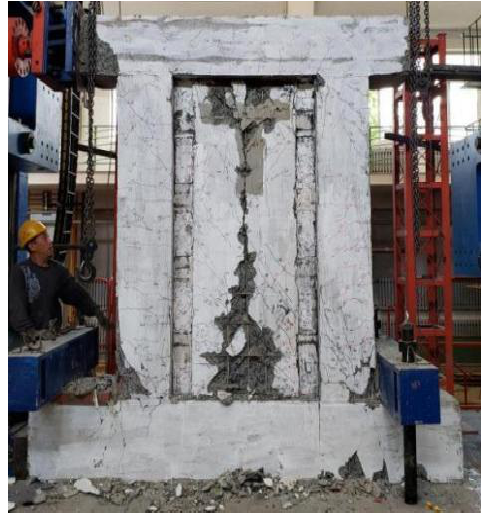
Figure 8. Final damage of specimen ZP.